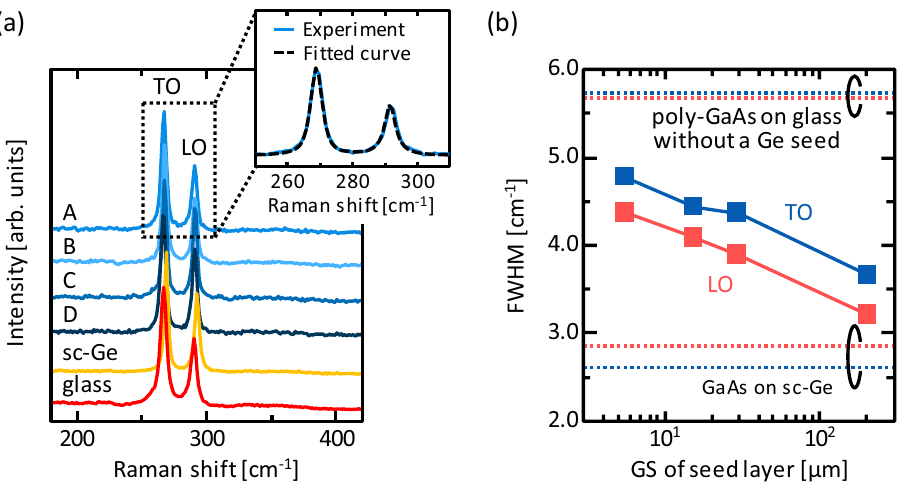
Figure 2. Raman spectroscopy study. ( a ) Raman spectra of samples in Group A ( T anneal = 375 °C), Group B ( T anneal = 375 °C), Group C ( C As = 1.2 × 10 20 cm −3 ), and Group D ( t AE = 3 min). Fitting result of Raman spectrum shown representatively in expanded view. ( b ) FWHMs of TO and LO mode Raman peaks for samples in Groups A–D. Data for GaAs layers grown on sc-Ge(111) wafer and glass without Ge seed layer are shown for comparison.